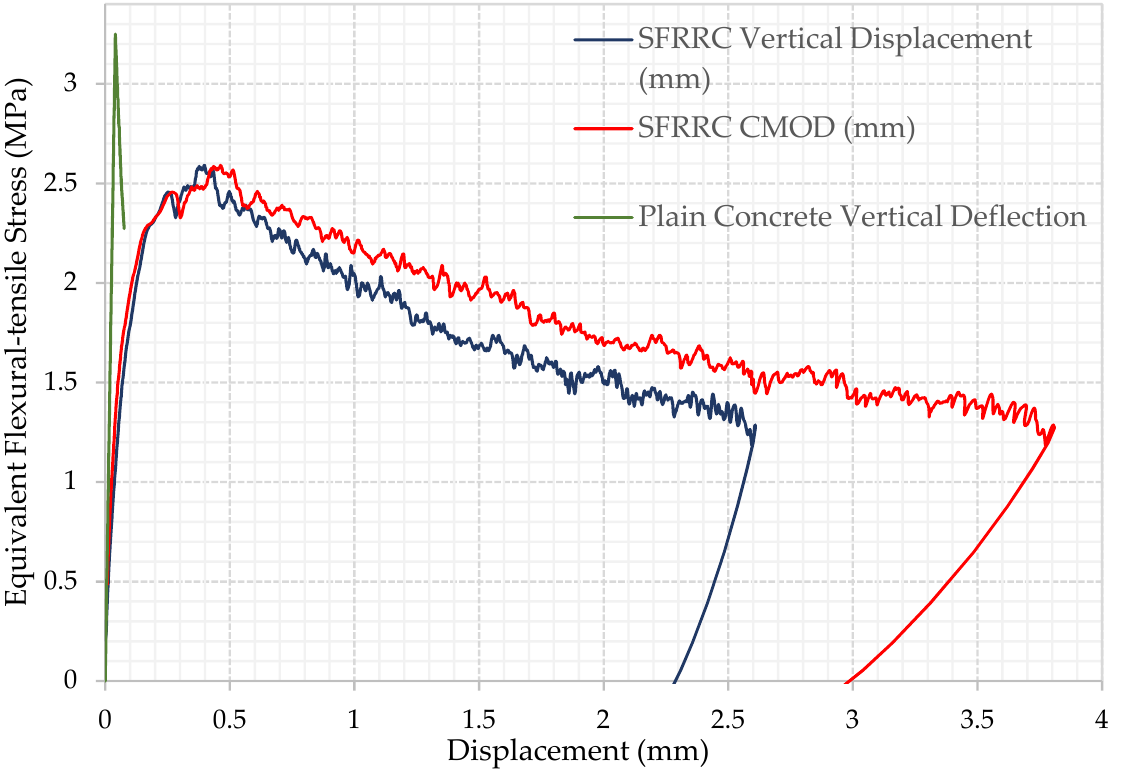
Figure 5. Equivalent Flexural-tensile stress vs. Displacement for Steel Fiber Reinforced Rubberized Concrete Specimen P5 and Plain Concrete Specimen PC1.